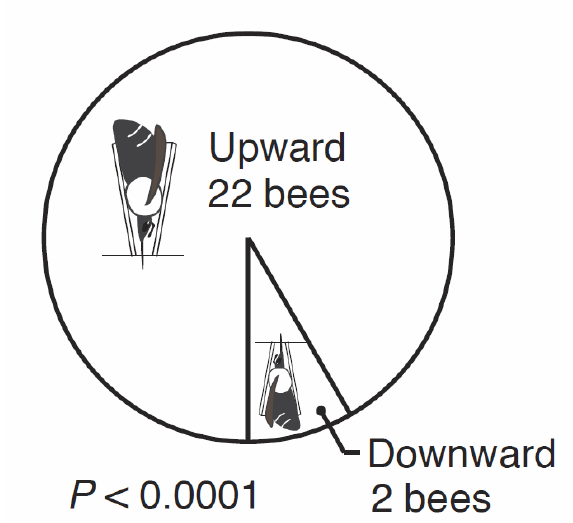
F IG . 2. The number of bees that chose upward- or downward- facing flowers at the very first visit ( n = 24 bees).